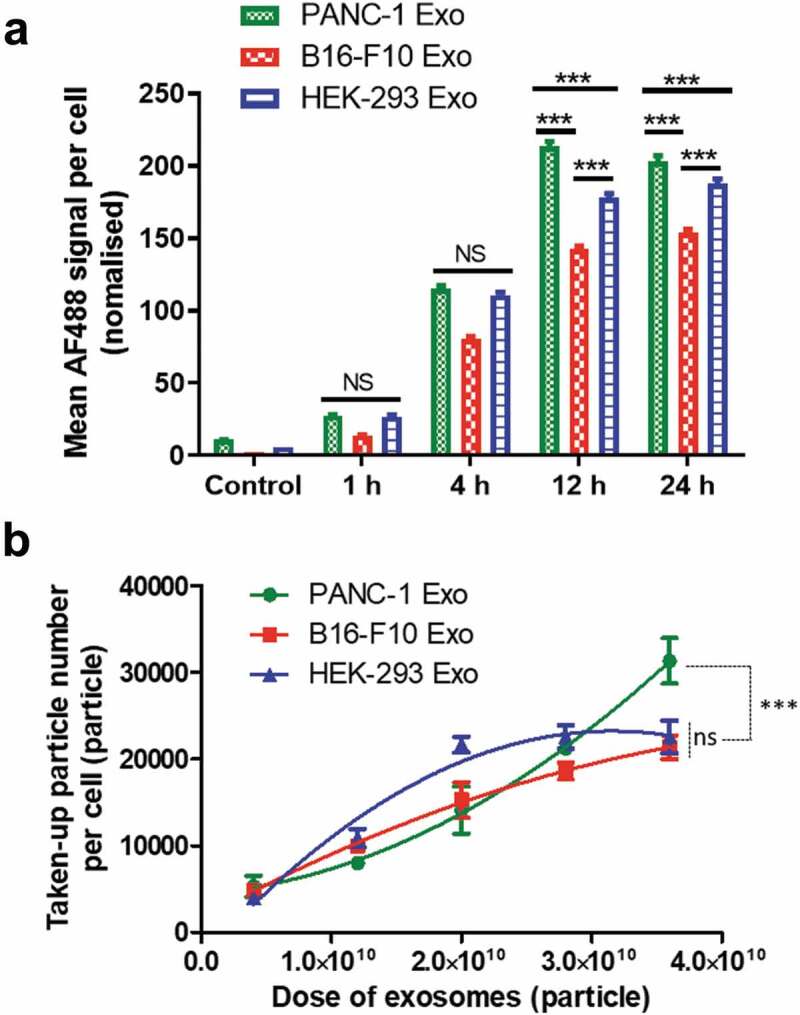
Effect of incubation time and exosome dose on in vitro exosome uptake in PANC-1 cells by imaging flow cytometry. (a) Time-dependent uptake profile of the three exosome types in PANC-1 cells. Each cell simultaneously imaged using the Imagestream Cytometer under the bright field and fluorescence (AF488) channels after incubation with labelled Exo for 1, 4, 12 and 24 h at a fixed dose of 2.0 × 1010 particles (sub-saturation level). Uptake was measured as the mean AF488 signal per cell, normalised according to the difference in labelling efficiency of the three exosomes. The error bars represent the s.e.m. (n > 2000 for all data). (b) Dose-dependent uptake profiles of the three exosome types in PANC-1 cells. PANC-1 cells were treated with each exosome at a dose of 4 × 109, 1.2 × 1010, 2.0 × 1010, 2.8 × 1010, 3.6 × 1010 particles for 24 h. Uptake was measured as the taken-up particle number per cell. Values are presented as mean ± SD (n = 3). Statistical analysis was done for the two longest incubation times in (a), and the highest dose for (b).